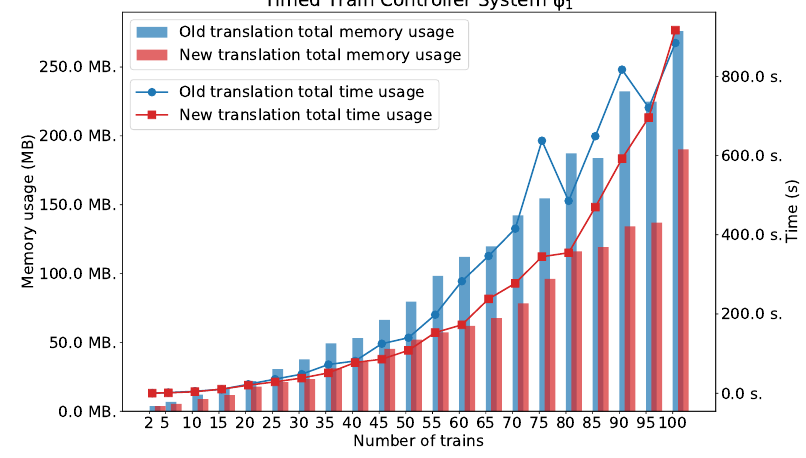
Figure 12. ϕ 1 : TTCS with n